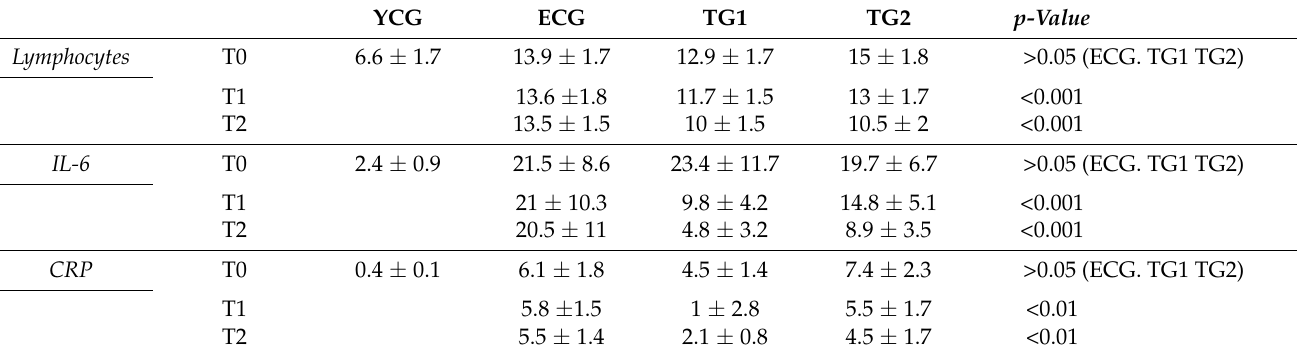
protein (CRP) in the young control group (YCG), the elderly control group (ECG), the treatment group 1 (TG1), and treatment group 2 (TG2). The p -values are reported in the last column of the table, and they refer to the comparison among the